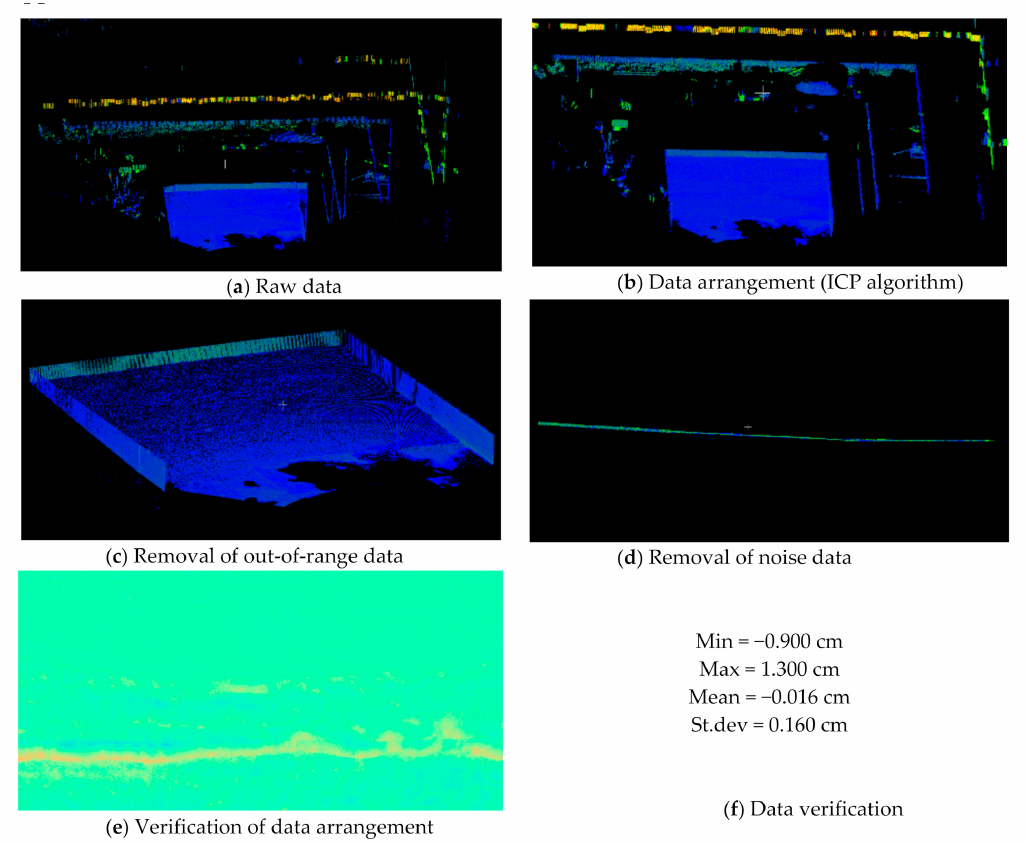
Figure A1. Data calibration for analysis of morphological